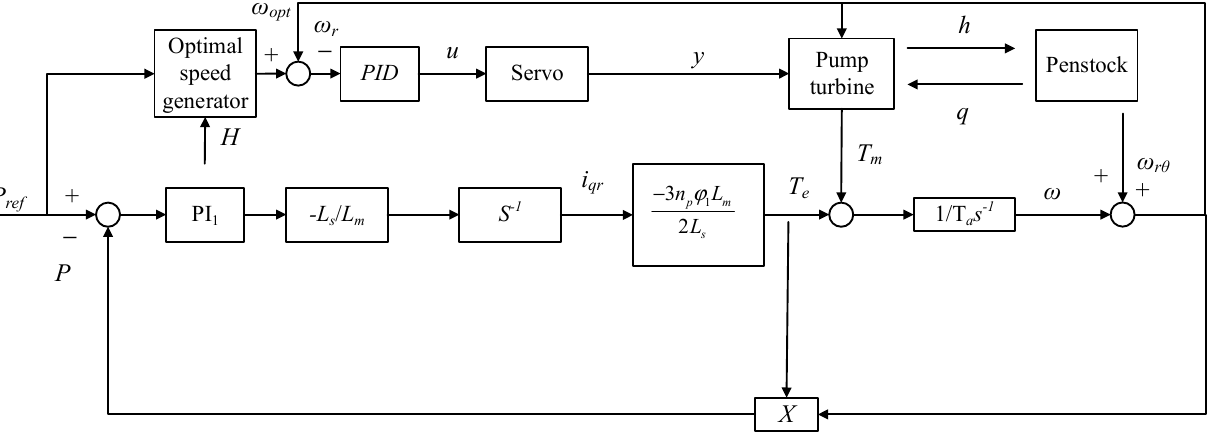
Figure 2. Control block diagram of the DFVSPSPS.